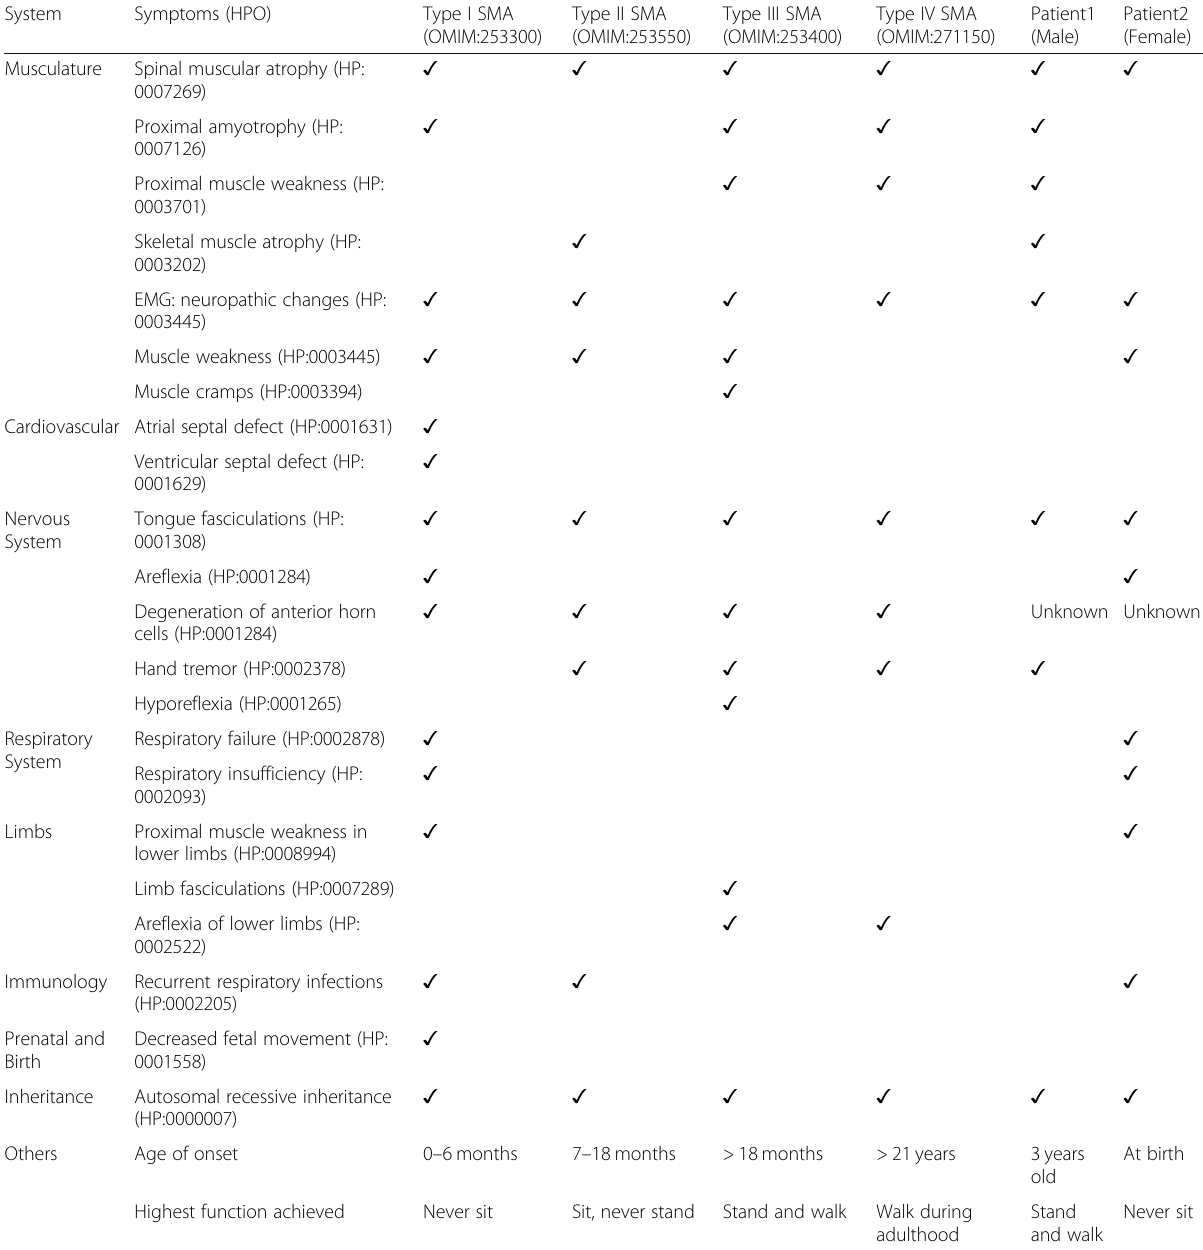
Table 1 The symptoms of four types of SMA and the SMA-discordant sibs